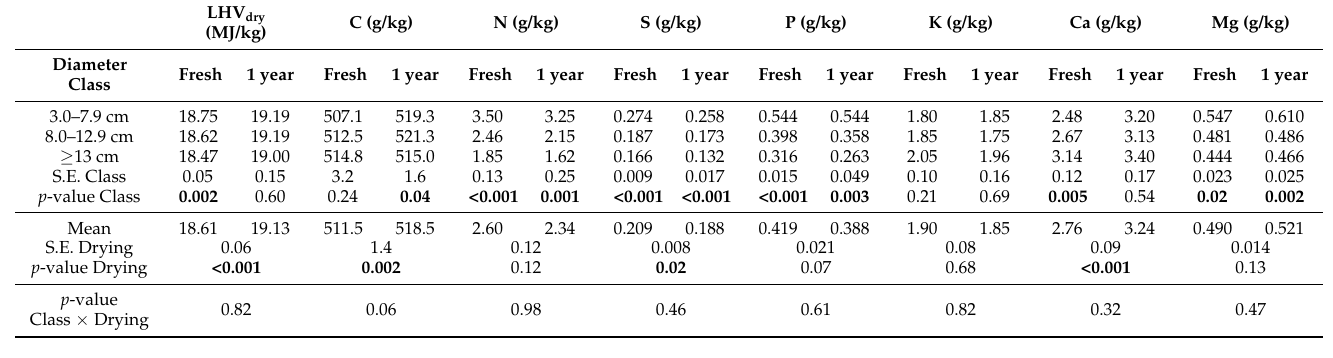
Table 2. Diameter class and drying treatment effects on chemical properties of unsplit hybrid poplar firewood logs (110 cm in length). S.E. = standard error of the mean. p -values in bold denote a significant effect.